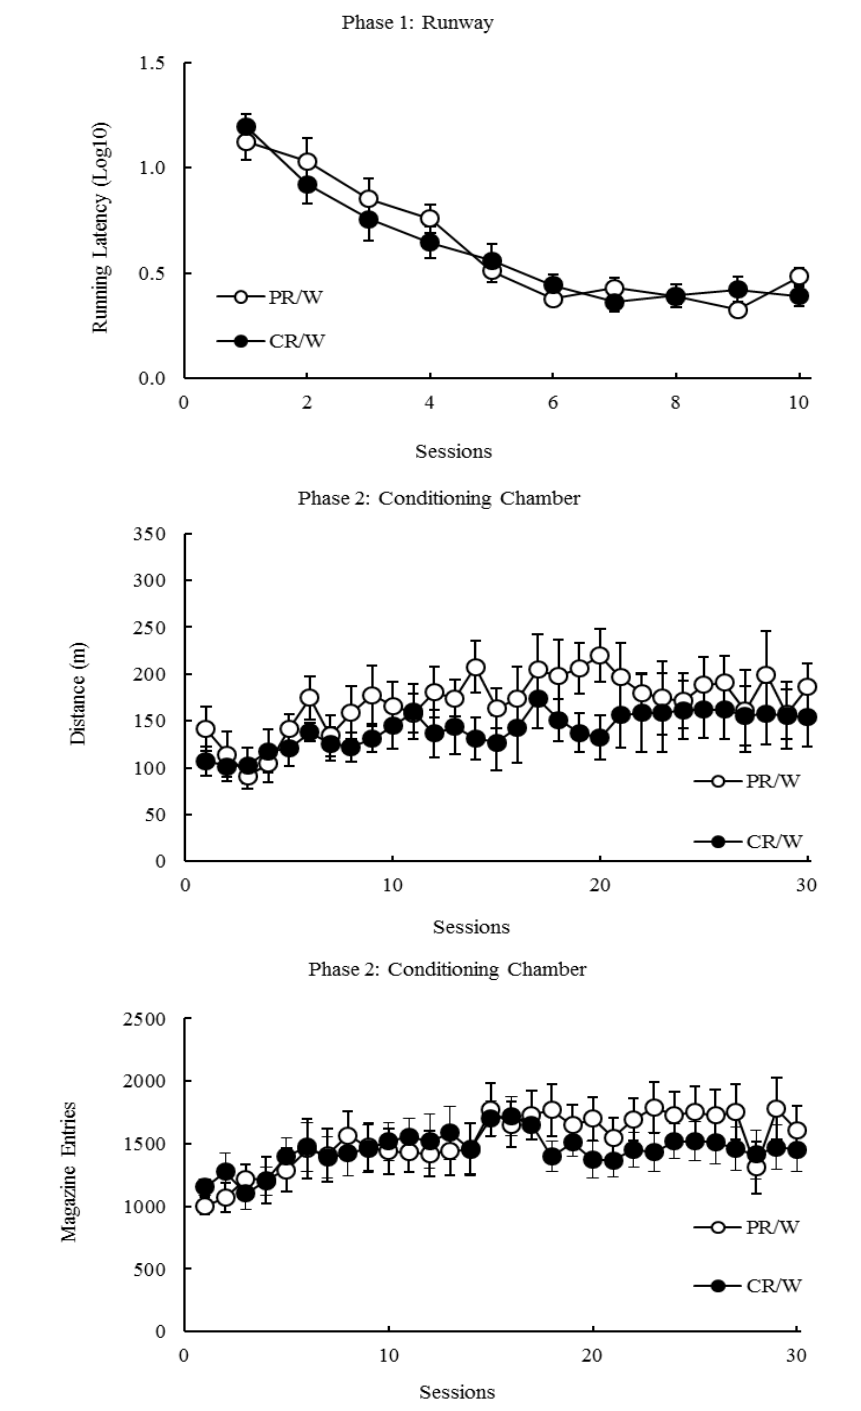
Figure 1 . Means (±SEMs) running latencies (in log 10 seconds) for partial reinforcement (PR/W) and continuous reinforcement (CR/W) groups during runway acquisition (top panel), meters ran in the activity wheel during FT 60 s in the conditioning chambers (middle panel), and magazine entries during FT 60 s in the conditioning chambers (bottom panel). PR: partial reinforcement; CR: continuous reinforcement; W: access to a wheel during intermittent reinforcement. Error bars were always included, but they are difficult to visualize in some